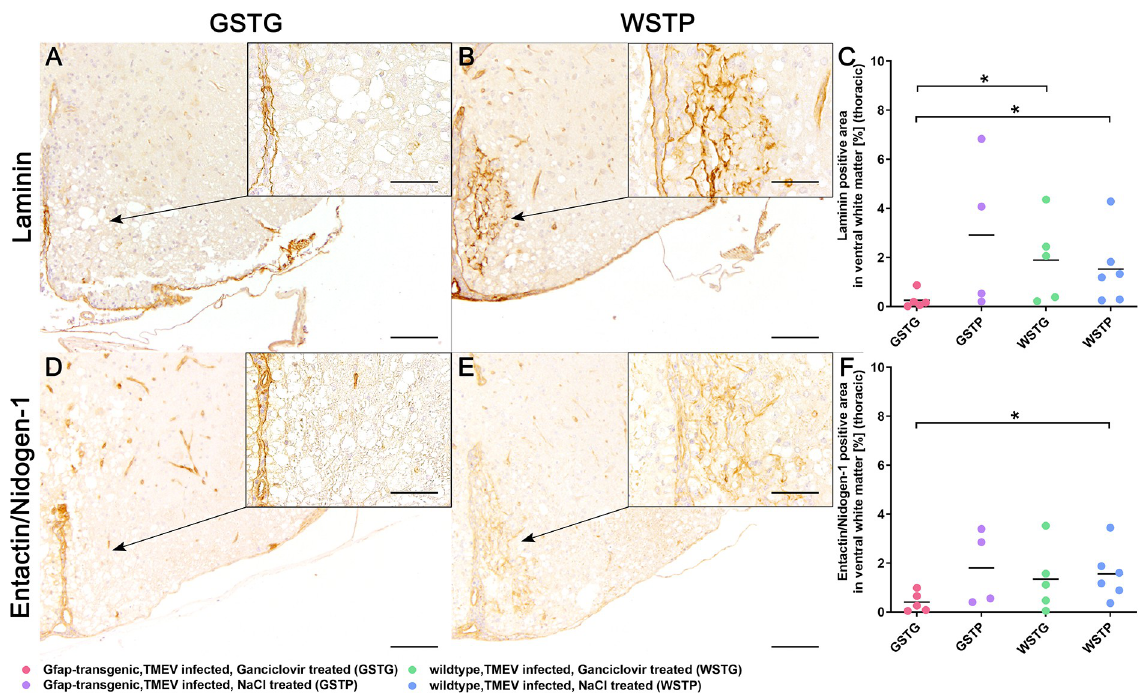
Fig 4. Impact of astrocyte depletion upon basement membrane extracellular matrix (ECM) components. Identification and quantification of basement ECM molecules was performed using immunohistochemistry identifying laminin ( A-C ) and entactin/nidogen-1 ( D-F ). Statistical analysis revealed a significant reduction of laminin and entactin/nidogen-1 in the lesioned ventral part of the thoracic spinal cord white matter in TMEV infected, ganciclovir treated, GFAP-transgenic (GSTG) mice at 77 dpi ( A, D ) compared to the non-astrocyte depleted control groups ( B, E ). Inserts visualize in more detail the increased intralesional accumulation of laminin ( B ) and entactin/nidogen-1 ( E ) in TMEV infected, natrium chloride (NaCl) treated wildtype (WSTP) animals compared to astrocyte depleted mice ( A , D ). For each antibody, one cross section of the thoracic spinal cord was evaluated per animal. Data are shown as scatter dot plots. The horizontal bar indicates the mean. Significant differences between GSTG and the control groups obtained by Kruskal-Wallis test followed by Mann–Whitney U post hoc tests are indicated by � , p � 0.05. Bars represent 100 μ m in overviews and 50 μ m in the inserts.